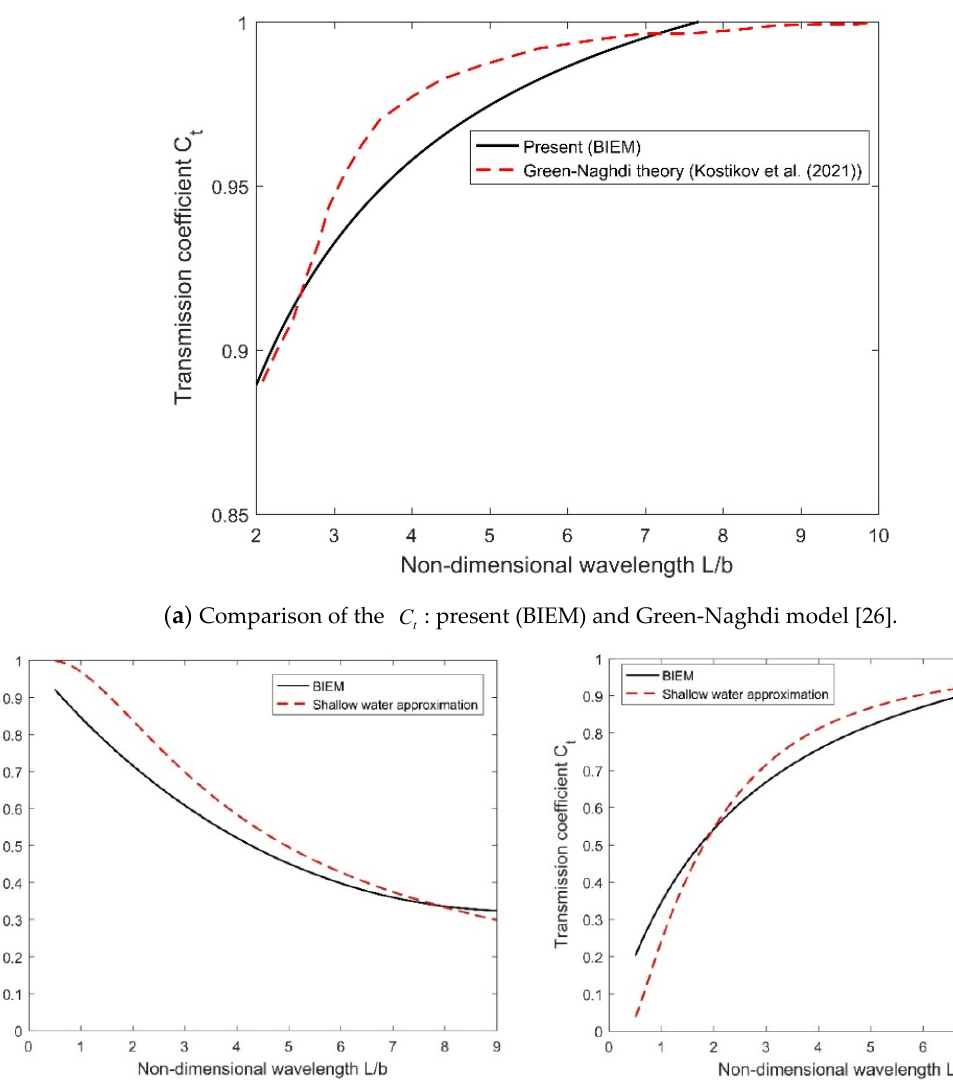
coefficients coefficients C r and C t